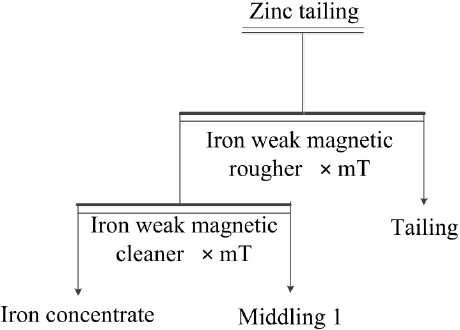
Minerals 2022 , 12 , x FOR PEER REVIEW Figure 14. Experimental flow chart of the effect of magnetic intensity. Figure 14. Experimental flow chart of the effect of magnetic intensity. Figure 14. Experimental flow chart of the effect of magnetic intensity.